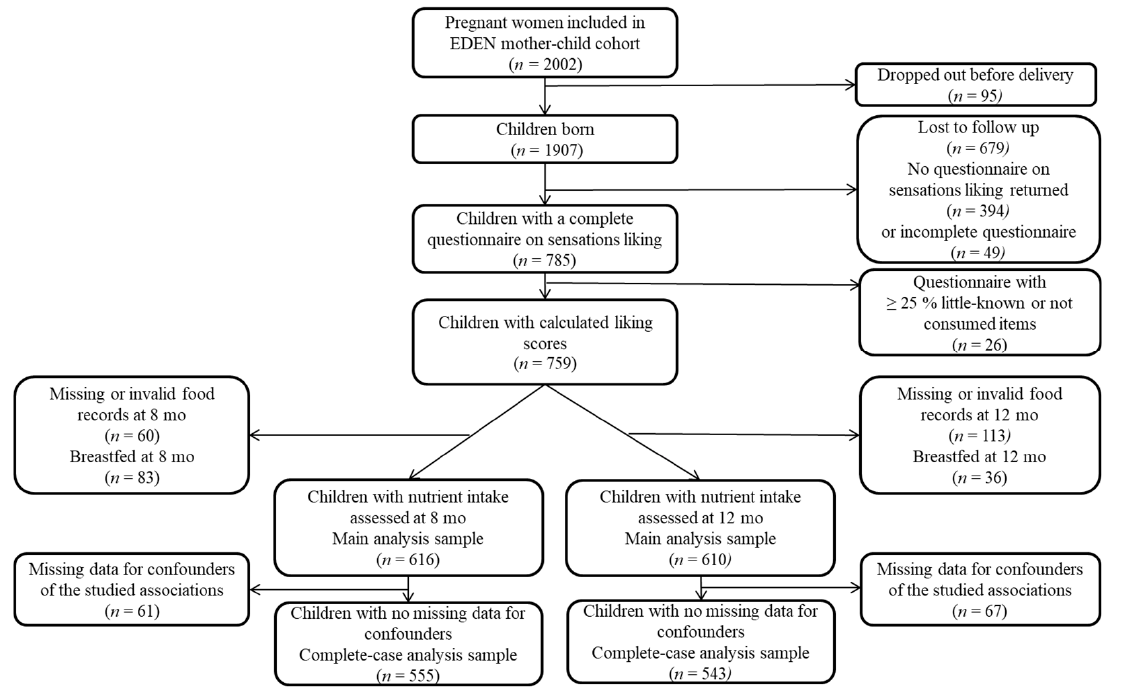
Figure 1. Sample selection flow chart.